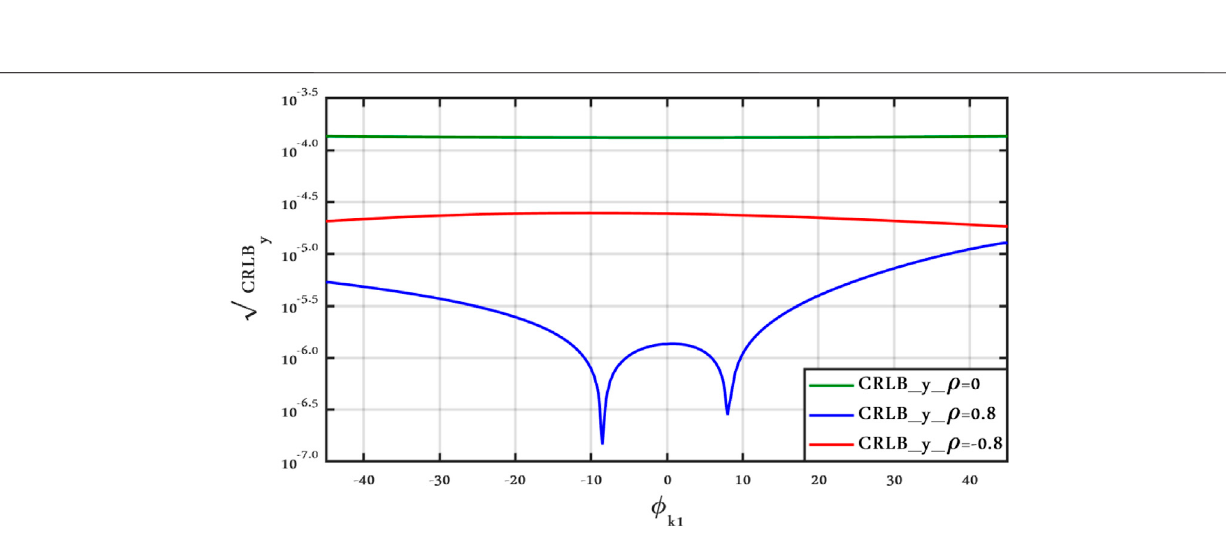
FIGURE 12 | CRLB y vs. ϕ k 1 antenna position, Clutter Model II for different ρ with ] = 2.1, SCR = 0 dB , and v x = v y = 50 m/s.